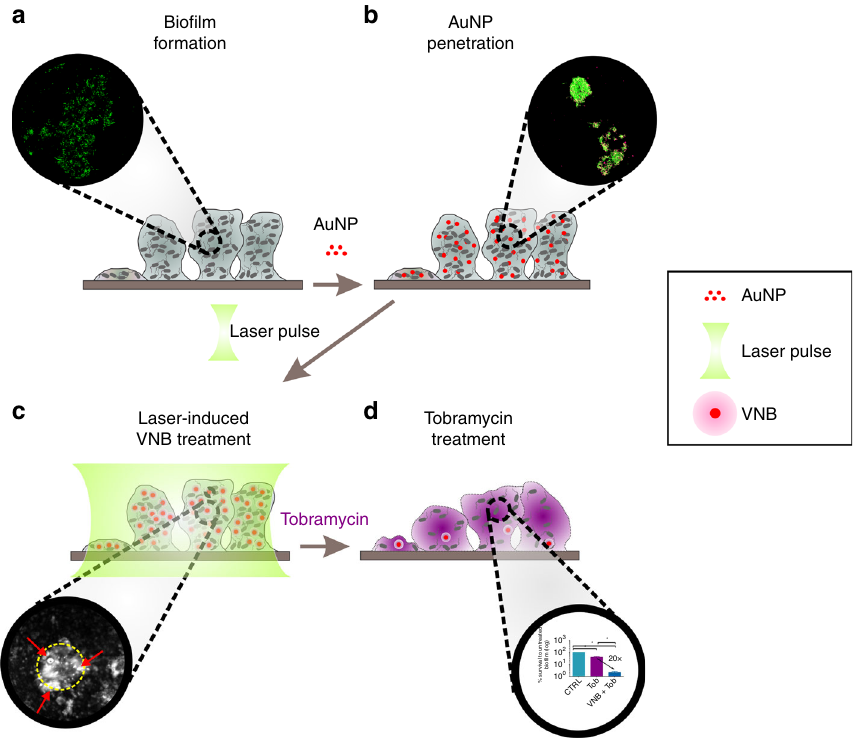
Fig. 1 Schematic overview of the experimental protocol. a Formation of a 24-h bacterial bio fi lm in vitro on a glass surface. b Penetration of AuNP through the bio fi lm. c After absorption of an intense nanosecond laser pulse, vapour nanobubbles emerge around the AuNP. d The mechanical force of VNB creates more space between the cells allowing better penetration of antimicrobial